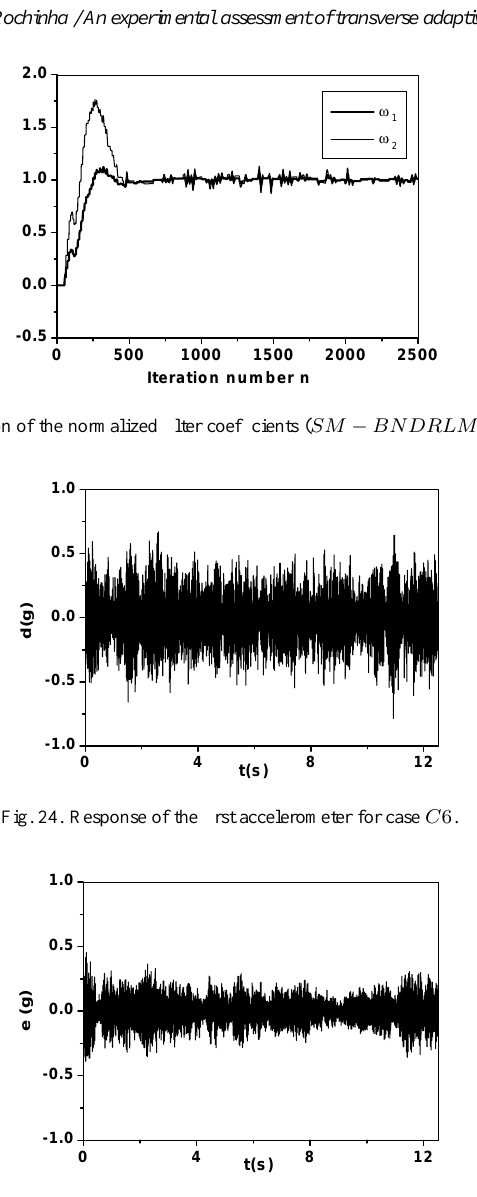
Fig. 25. Error function based on the LMS algorithm for the case C 6